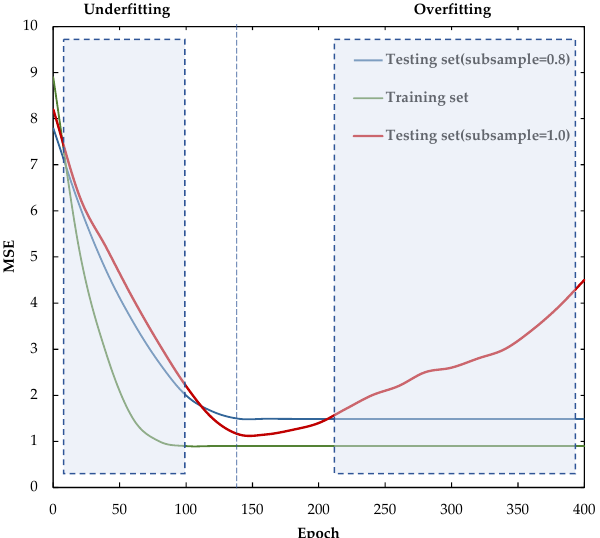
Figure 7. Learning curves for training set and testing